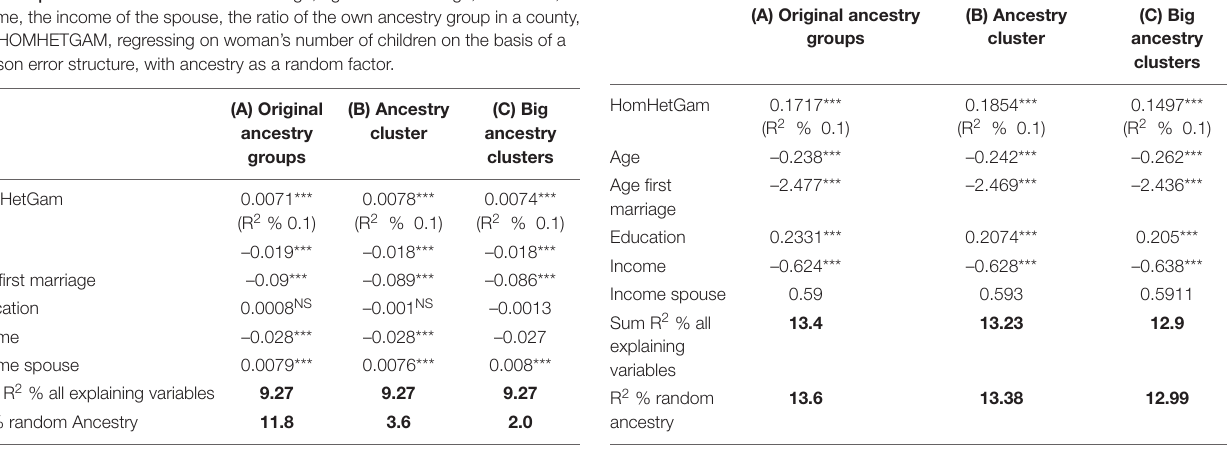
TABLE 7 | General linear mixed model of HOMHETGAM, age, age at first marriage, education, income, the income of the spouse, and the ratio of the own